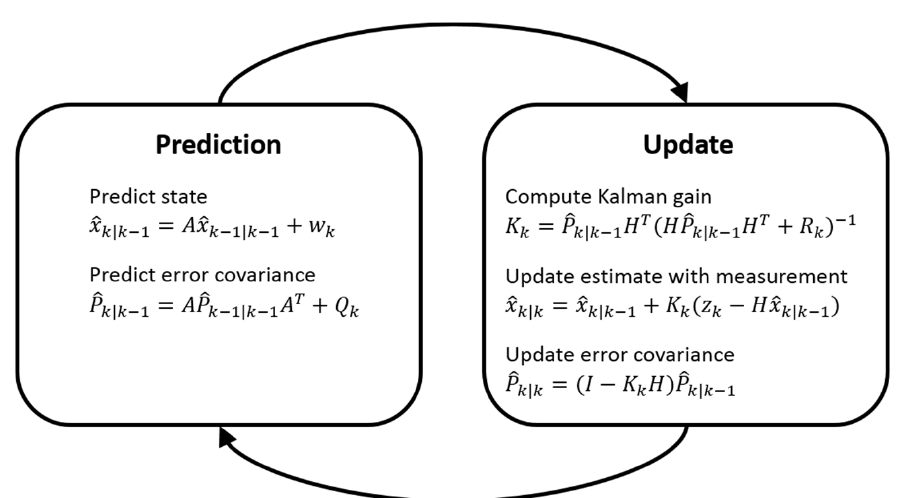
Figure 2. Operation of the Kalman filter algorithm.